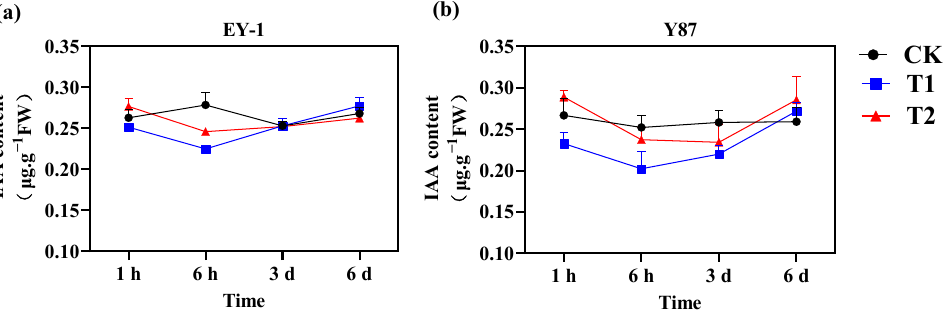
Figure 4. Changes of endogenous hormone IAA content in shoots of EY-1 ( a ) and Y87 ( b ). CK, control; T1, topping; T2, IAA application after topping. The mean ± SE of three replicate samples are shown as error bars. FW: fresh weight.